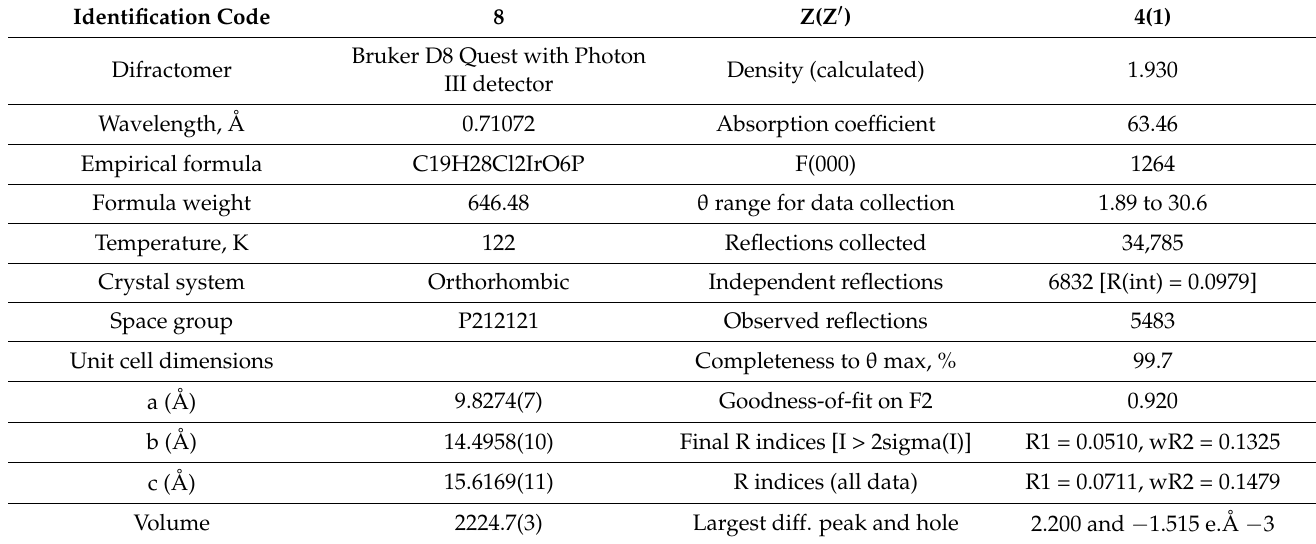
Table 2. Crystallographic data for 8 .